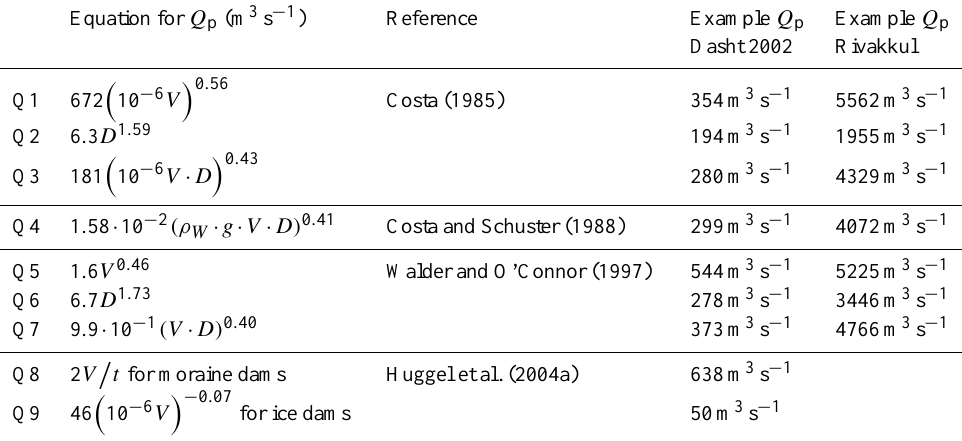
Table 6. Empirical equations relating peak discharge Q p to outburst volume V and lake depth resp. dam height D . ρ w =density of water (kgm − 2 ) , g =gravity (ms − 2 ) . The examples refer to the computed peak discharges of the Dasht event 2002 (lake area: 37000m 2 ) and a hypothetic complete drainage of Rivakkul (1.2km 2 )